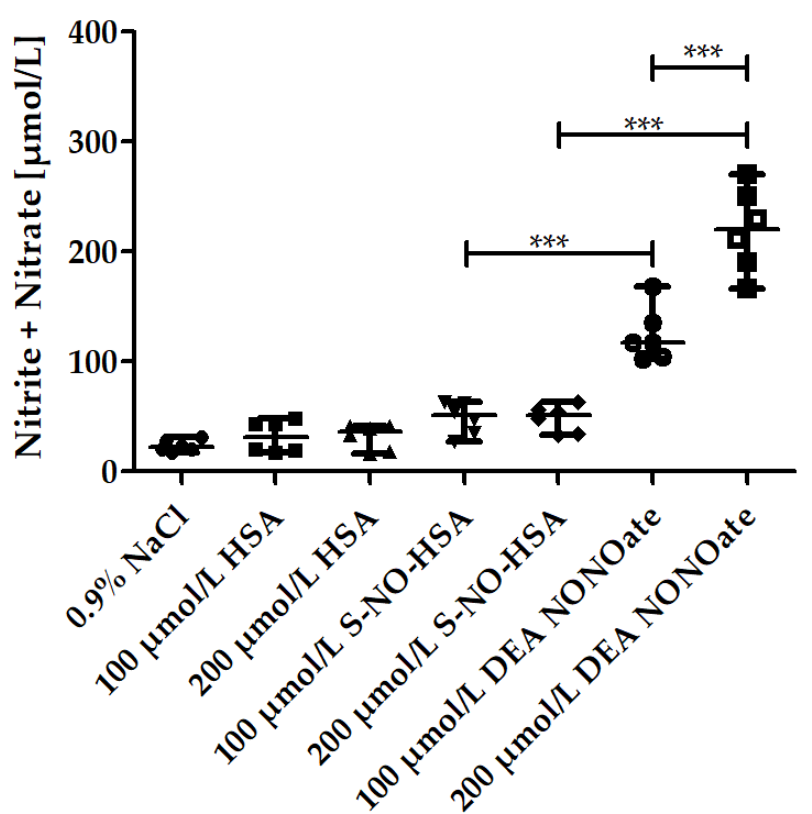
Figure 1. Nitrite/nitrate amounts in the presence of increasing concentrations of S-NO-HSA or DEA-NONOate in WB. The increase in the sum of nitrite and nitrate amounts in µmol/L served as a measure for NO release from the NO-donors in WB. Significantly higher amounts of NO were released by DEA-NONOate (100 and 200 µmol/L final concentration) than by equimolar amounts of S-NO- HAS after 6 min aggregation. ANOVA and Bonferroni post-test were used to evaluate differences in plasma levels of nitrite/nitrate. The results are presented as median with range ( n = 6). *** p ≤ 0.001.